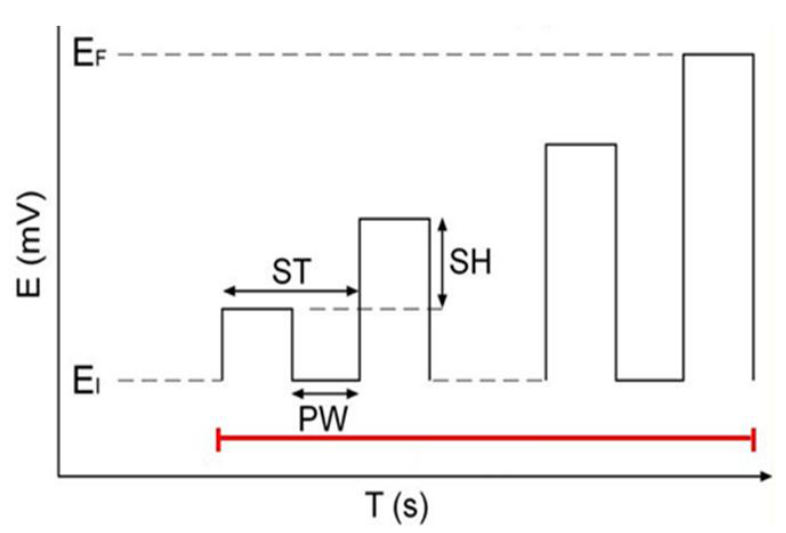
Figure 2. Scheme of the anodization procedure applied to the NiTi made in an electrolytic reactor. The samples anodized were cleaned by ultrasounds in ethylic alcohol, double-distilled water and acetone for 15 min each one.